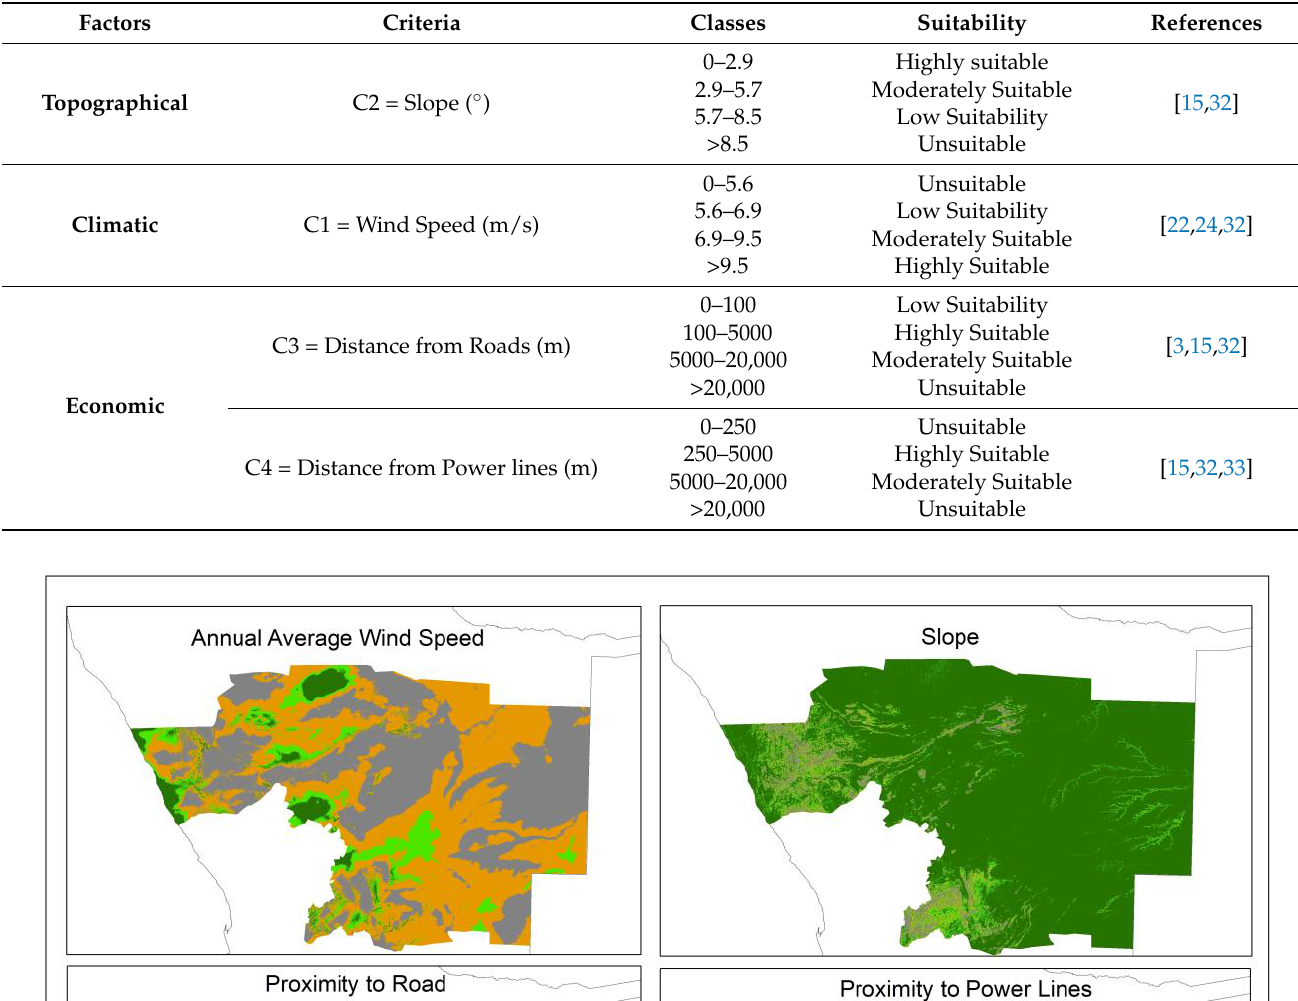
Table 7. Factors for wind turbine power plant installation.